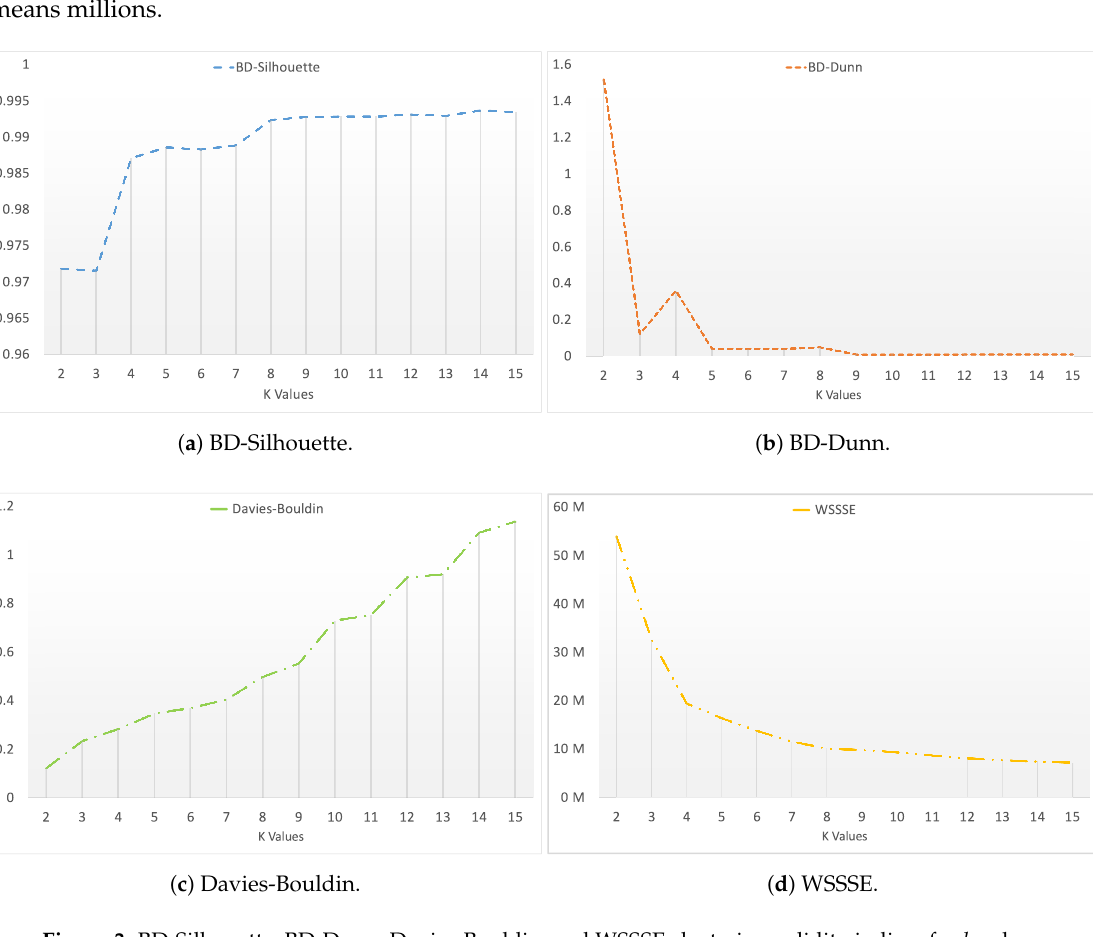
Figure 3. BD-Silhouette, BD-Dunn, Davies-Bouldin, and WSSSE clustering validity indices for k values from 2 to